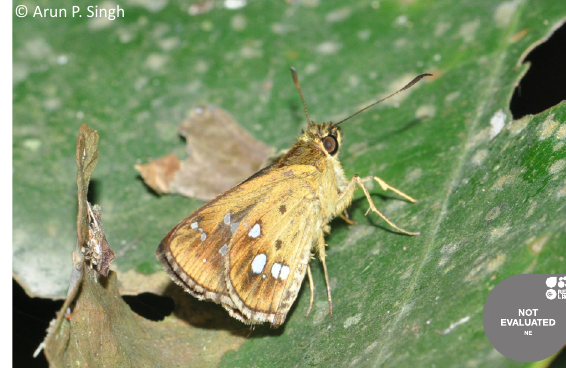
Image 4. Dark Archduke Lexia dirtea khasiana (male) (locally common)